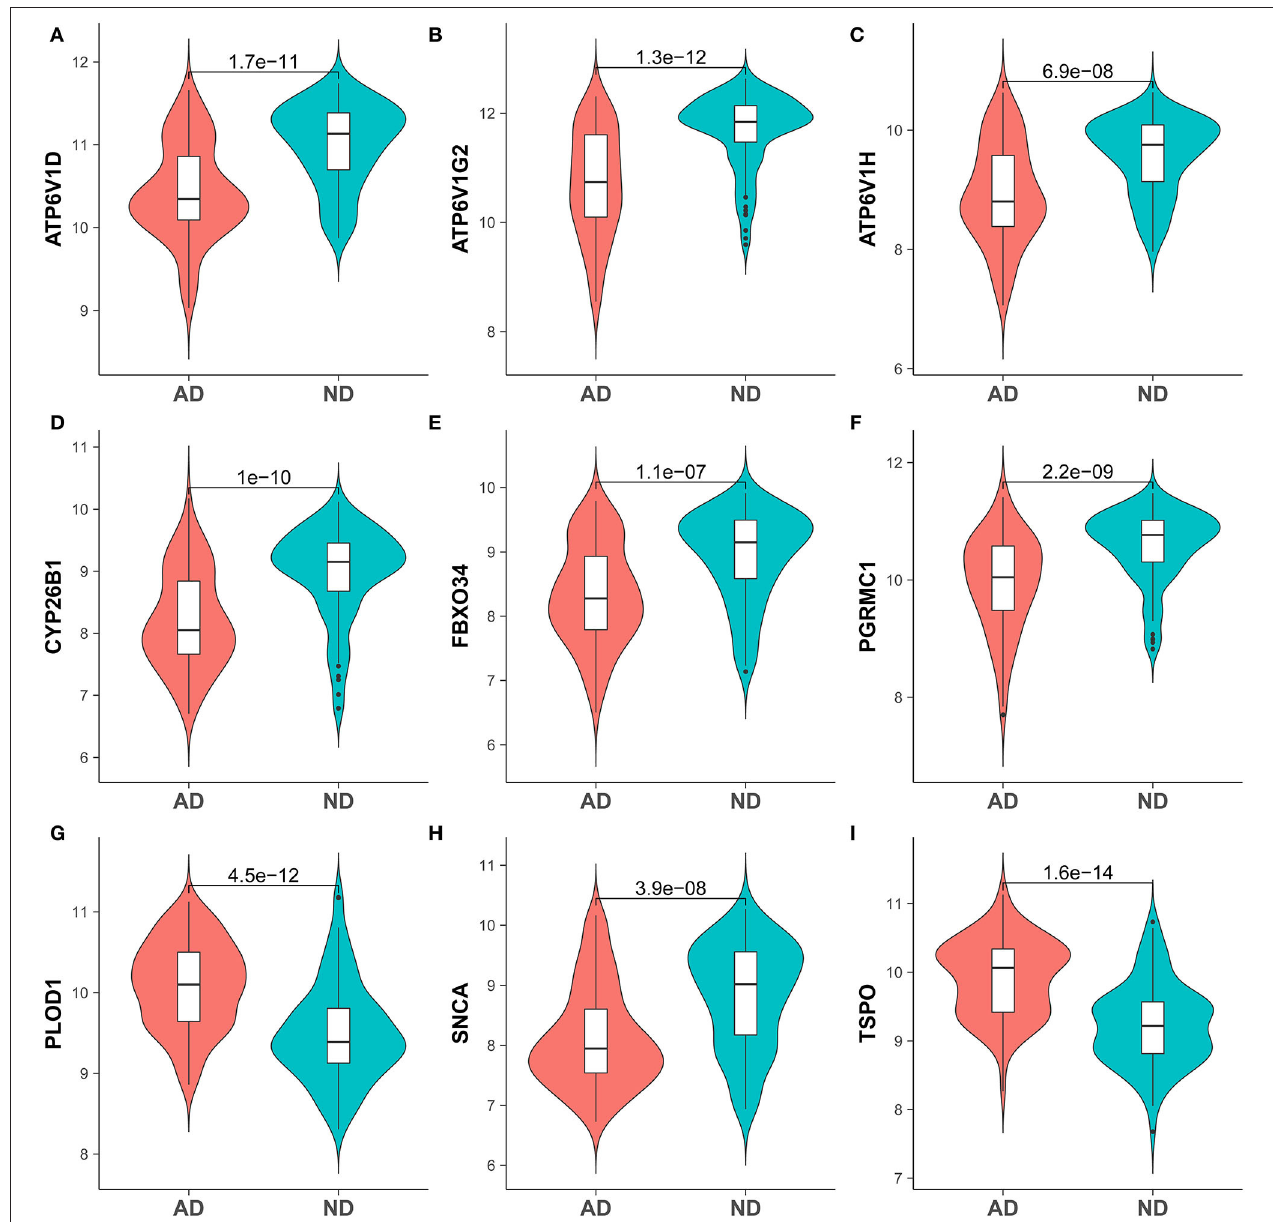
FIGURE 5 | Expression of hub genes in the AD and ND groups of brain tissue samples GSE132903. (A) ATP6V1D, (B) ATP6V1G2, (C) ATP6V1H, (D) CYP26B1, (E) FBXO34, (F) PGRMC1, (G) PLOD1, (H) SNCA, and (I)